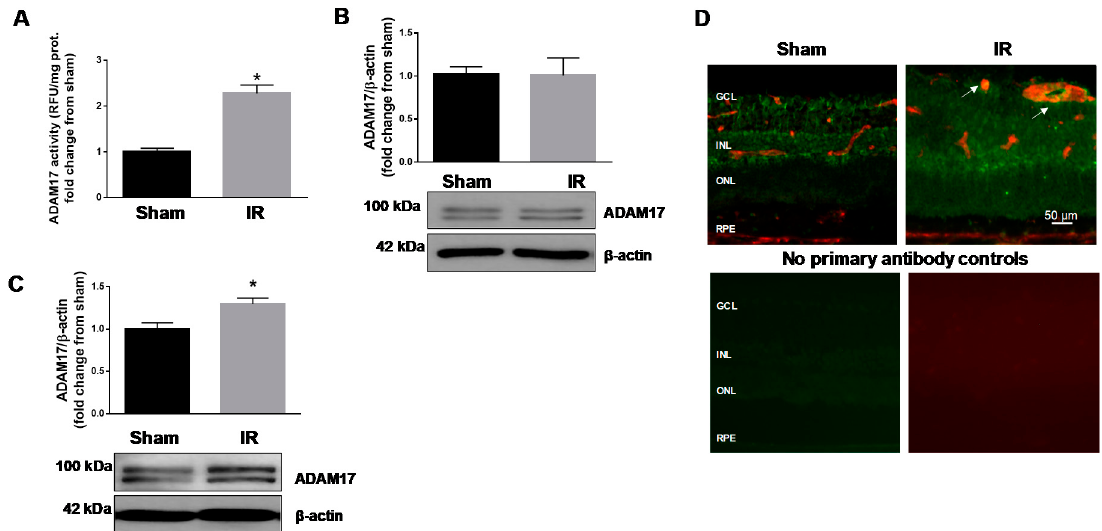
Figure 1. ADAM17 expression and enzymatic activity are increased in retinas of C57Bl/6J mice subjected to retinal IR (ischemia reperfusion). ( A ) ADAM17 enzymatic activity and ( B ) protein expression in IR-injured and sham-operated eyes of C57Bl/6J mice 6 h after IR were evaluated by fluorimetric assay and Western blotting analysis, respectively. Values are mean ± standard error (SE). Results are presented as a fold change from sham. * p < 0.001 vs corresponding sham; n = 5 in each group. ( C ) Western blotting analysis of ADAM17 expression 48 h after reperfusion. Blots were subjected to densitometric analysis and the obtained data were analyzed for statistical significance. Actin was used as an internal control. Values are mean ± SE. Results are presented as a fold change from sham. * p < 0.05 vs corresponding sham; n = 5 in each group. ( D ) Representative immunofluorescence images show expression of ADAM17 (green) in retinal vessels of IR-injured and sham-operated eyes 48 h after IR (white arrows). Retinal blood vessels were co-labeled with anti-CD31 antibody (red); n = 3 in each group. Scale bar, 50 µm. GCL, ganglion cell layer; INL, inner nuclear layer; ONL, outer nuclear layer; RPE, retinal pigment epithelium.